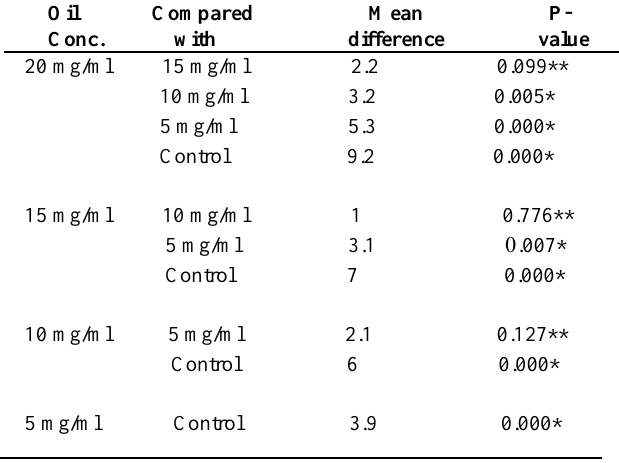
Table 2: Comparison among the antifungal activity (inhibition zone diameter in mm) between each two concentration of Nasturtium officinale oil and calcium hydroxide paste (control) against Candida albicans